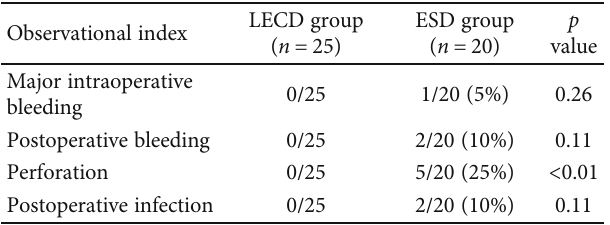
Table 3: Comparison of postoperative complications between LECD group and ESD